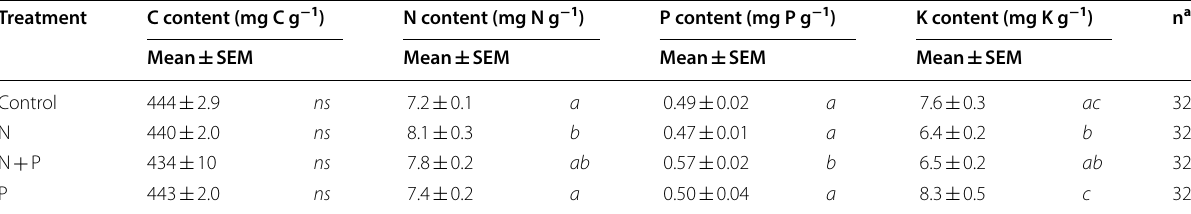
For each measured element the differences between treatments are indicated with italic letters, identical letters indicate no difference ns not significant a As n was the same for each measurement it is only mentioned once here. CH 4 addition treatment was merged with its control, resulting in doubling of the